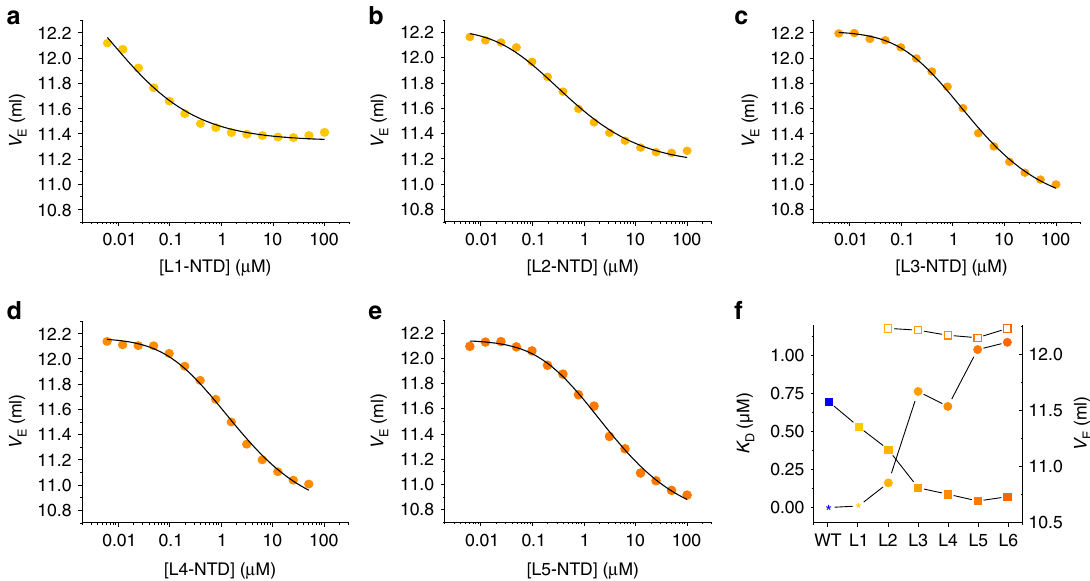
Fig. 4 Dimerization of cumulative Met-to-Leu mutants. a – e V E plotted versus protein concentration of cumulative Met-to-Leu mutants L1 to L5 measured using high-resolution SEC. The black lines are fi ts to the data using a thermodynamic model for a monomer/dimer equilibrium. f Values of K d (spheres) and end-point values of V E (squares) of cumulative Met-to-Leu mutants (L1 to L6) and of WT-NTD measured using high-resolution SEC. The K d of WT-NTD is the value determined from kinetics reported in ref. 11 . The K D of L1 is an estimate because of the non-de fi ned monomer baseline. Closed and open squares are end-point V E values of dimer and monomer, respectively. The end-point values of V E of the WT-NTD monomer and of the L1-NTD monomer could not be determined because their K d was too low to enter baseline region. Source data are provided as Source Data fi